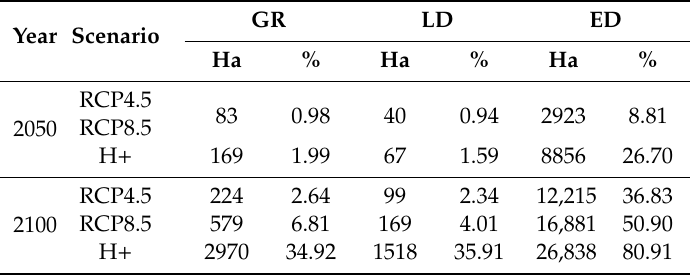
Table 4. Inundation-prone area (ha) and the proportion (%) of study areas inundated using a pseudo-dynamic inundation method under di ff erent RSLR scenarios at given time horizons.